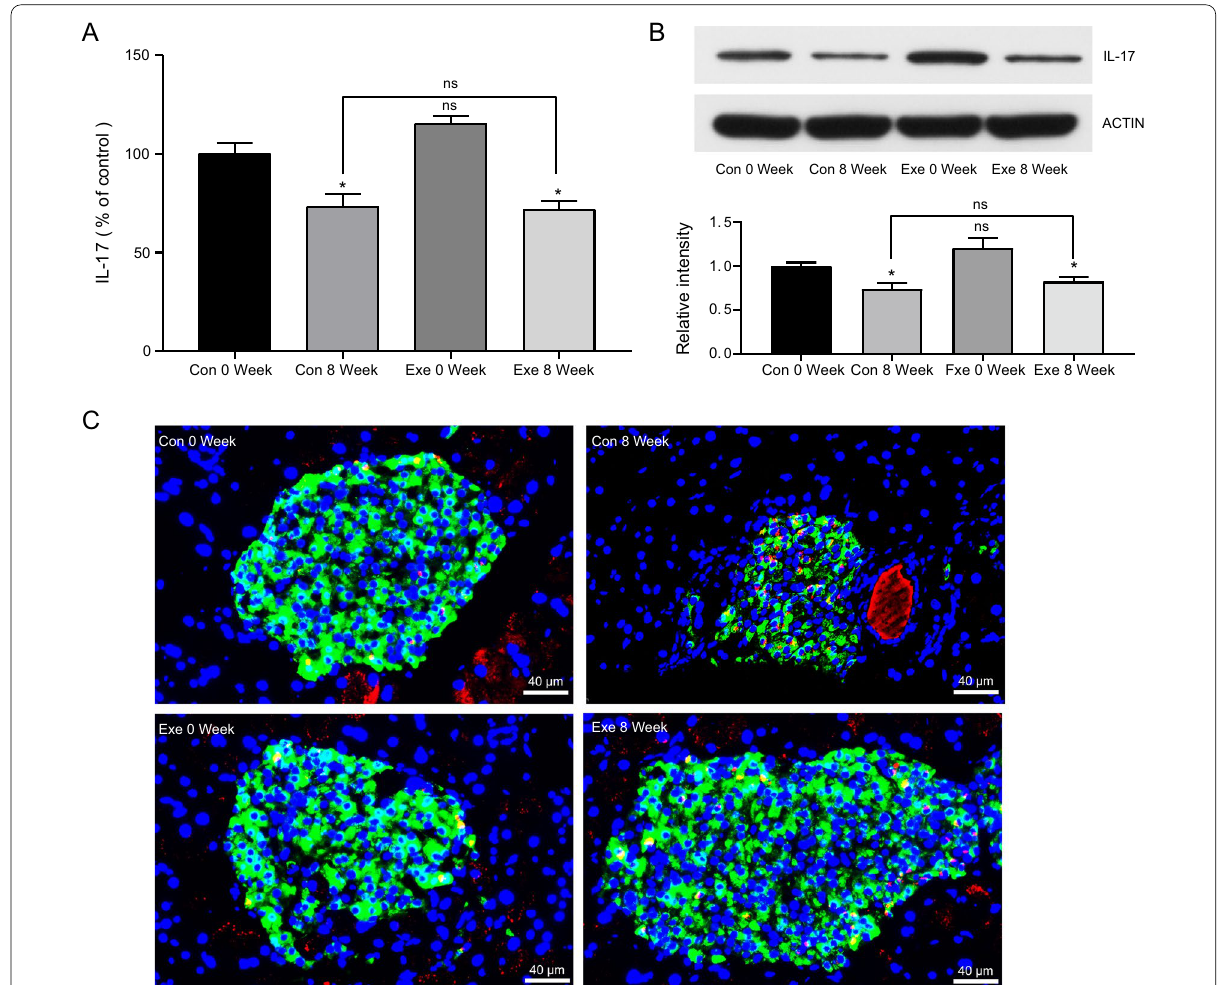
Fig. 3 Detection of Th17 cells in pancreas from control (Con) and exenatide (Exe) groups at week 0 and week 8. A mRNA levels of IL-17 by real-time PCR. mRNA quantities were calculated as a ratio to the level of GAPDH mRNA in each sample. Data are shown as the relative expression ratio to Control 0 Week. Results are expressed as mean SEM, n 8 in each group. B Representative image and gray value analysis of IL-17 by western blot. ± = ACTIN was used as a loading control. Data are shown as the relative expression ratio to Control 0 Week and expressed as mean group. C Representative immunofluorescence of pancreatic sections using anti-IL-17 staining (red), anti-insulin staining (green) and DAPI staining (blue), scale bar 40 μm, n 8 in each group. * P < 0.05 vs control 0 week; ns P > = =